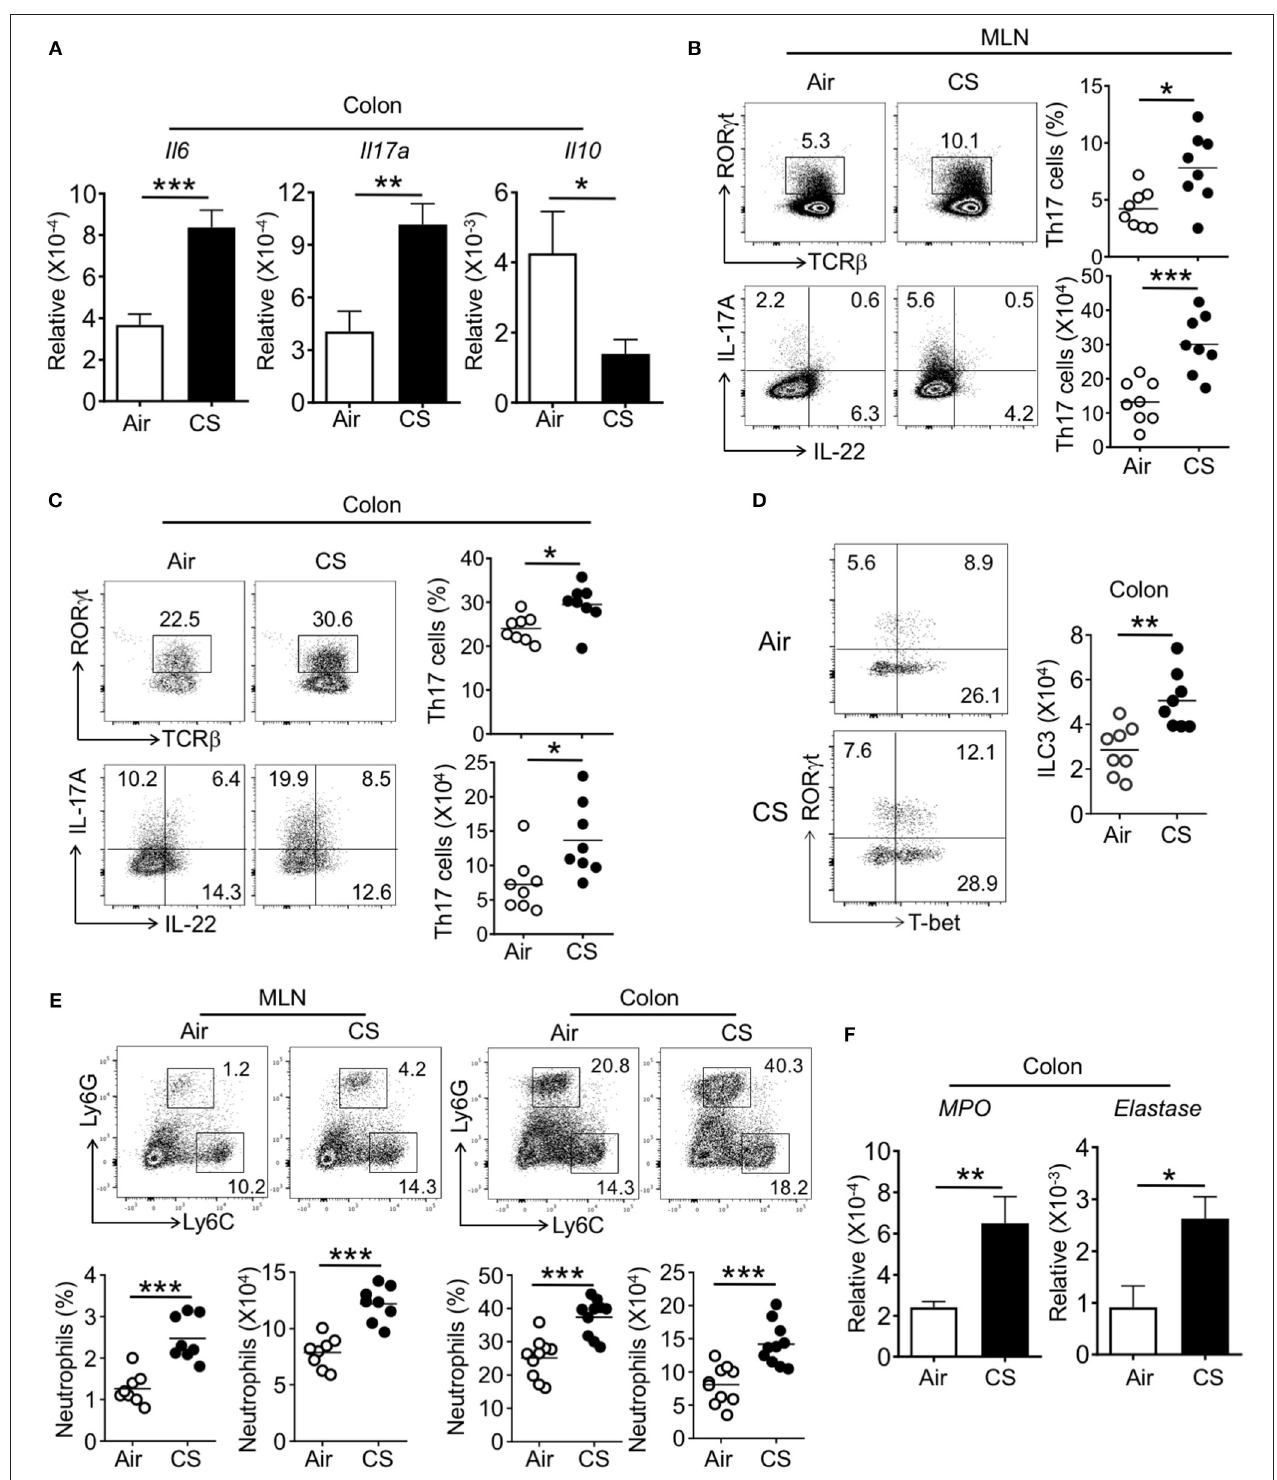
FIGURE 5 | Cigarette smoke exposed mice display elevated intestinal Th17 cell and neutrophil responses after DSS challenge. Mice were exposed to air or CS for 2 months followed by 2% DSS for 6 days. Mice were sacrificed at 9 days post-DSS treatment. (A) mRNA expression for indicated cytokine in the colon from DSS treated Air and CS mice as determined by qRT-PCR. (B,C) Frequencies (%) and absolute numbers of Th17 cells in MLN and colonic lamina propria from DSS treated Air and CS mice as determined by flow cytometry. Representative dot plots are shown and frequencies and numbers of IL-17A + Th17 cells (CD3 + CD4 + IL-17A